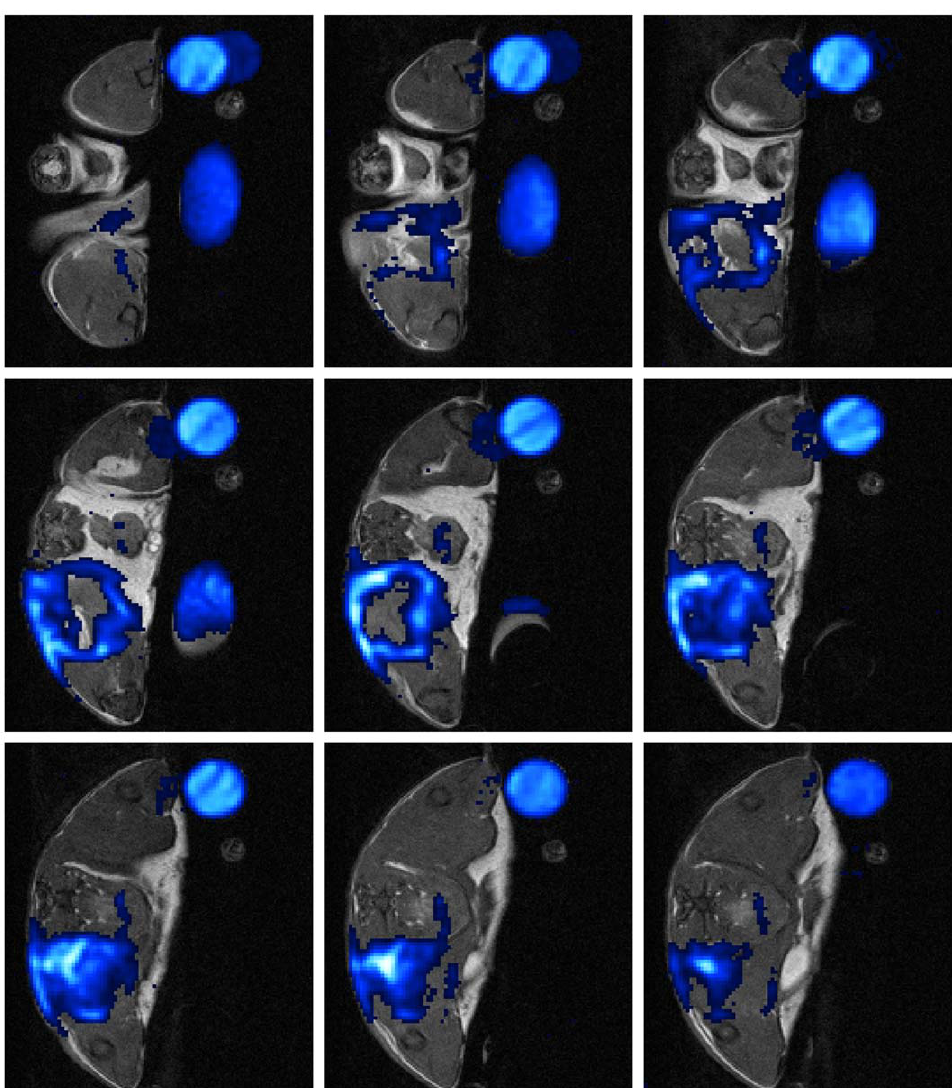
Figure 3. Representative MR-slice series showing the hollow sphere formed by PFC at acute phase. The depicted mouse received PFC at day 2 after start of infection. Images were recorded 24 h after administration. 19 F-SSFP CSI overlay on 1 H-TSE image of PFC group mouse shows strong accumulation of PFC at the rim of the abscess area.(Slice Thickness: 1 mm, FOV 25 6 25 mm 2 , Co: Control tube filled with PFC dilution, R: right side, L: left side of the imaged mouse).